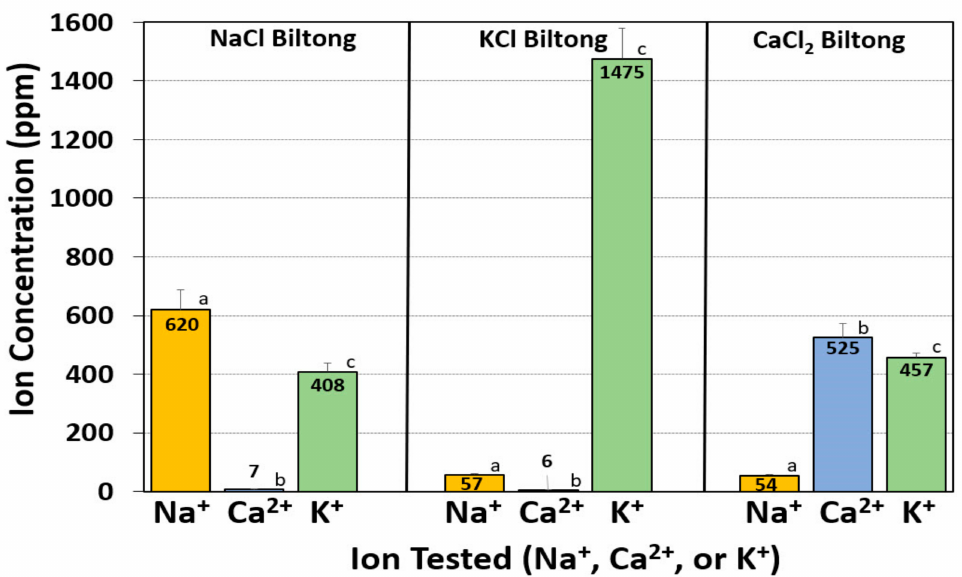
Figure 4. Analysis of Na + , Ca 2 + and K + ions in biltong made with NaCl, KCl, or CaCl 2 . Comparison of all 3 ion concentrations in in each batch of biltong made with a single added salt. Data are presented as the mean of triplicate replications and error bars represent the standard deviation from the mean. Statistical analysis was only performed on ion analyses within the same biltong salt formulation. Means with the same letter are not significantly di ff erent ( p > 0.05) whereas means with di ff erent letters are significantly di ff erent ( p <